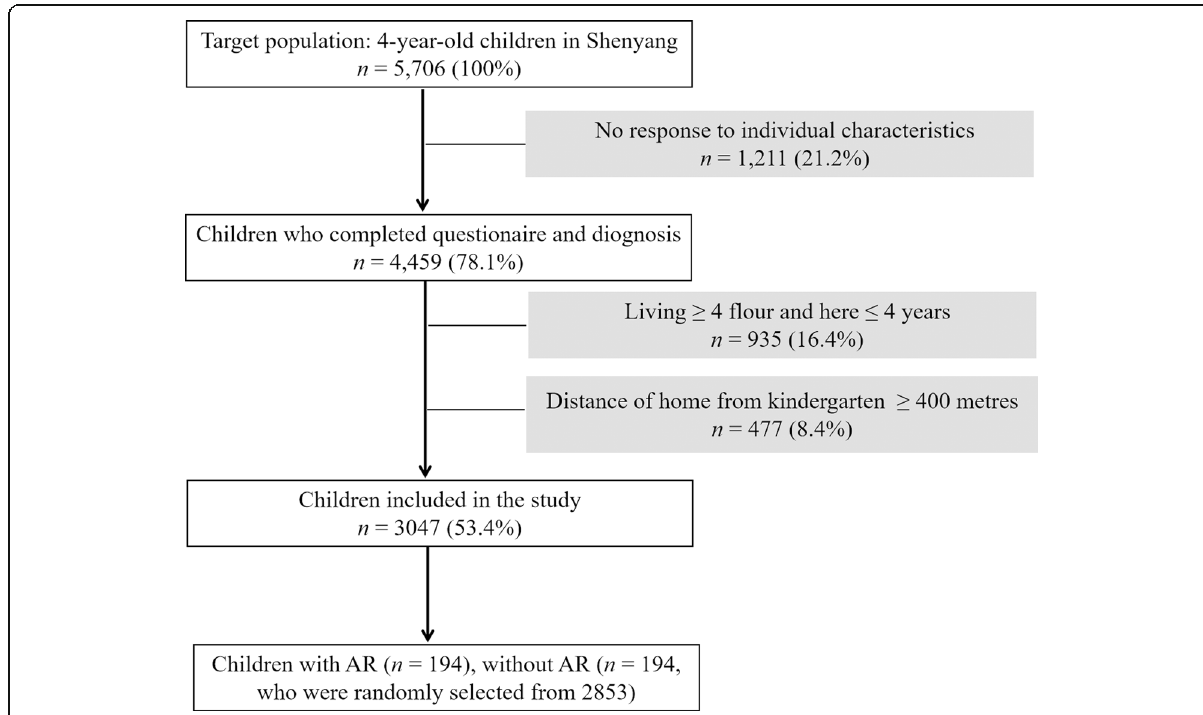
Fig. 1 The flow chart of cases and controls selection